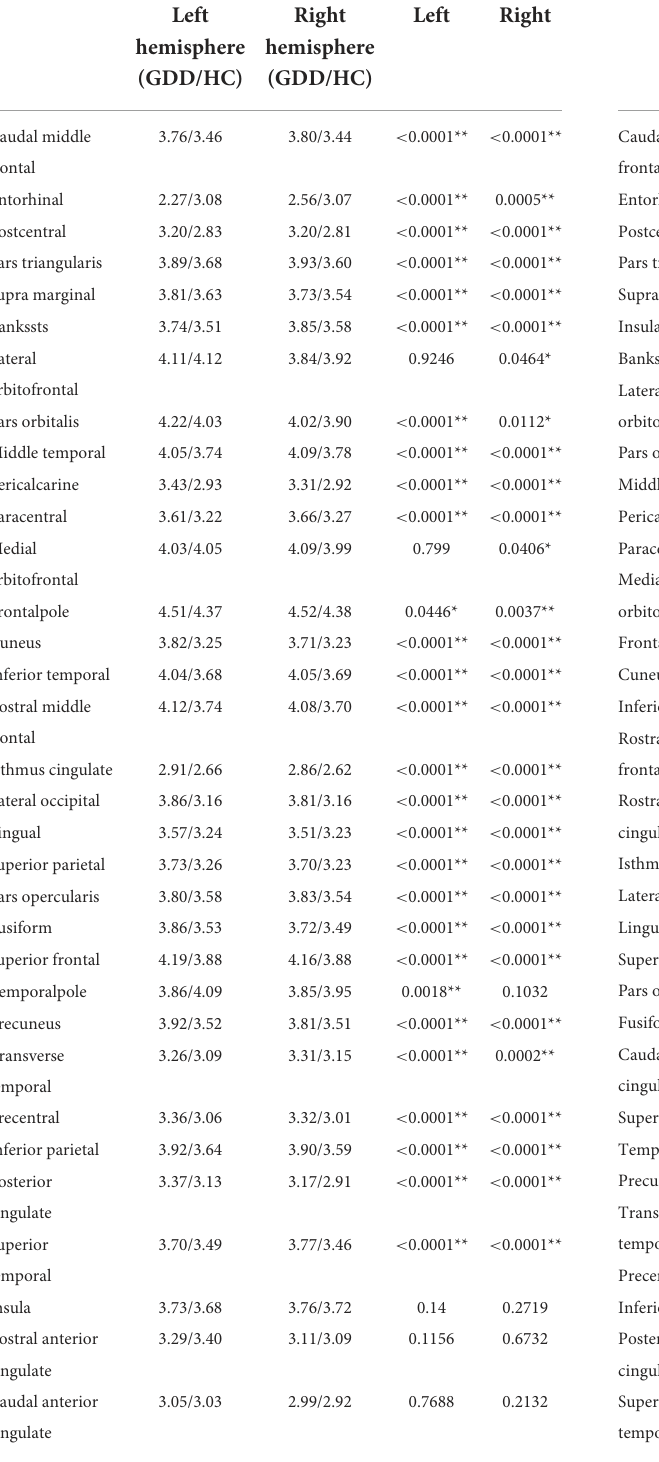
TABLE 1 Brain cortical regions that show significant differences in cortical thickness (CT) between the two groups. Brain region CT (mm) P Left Right Left Right hemisphere hemisphere (GDD/HC) (GDD/HC)